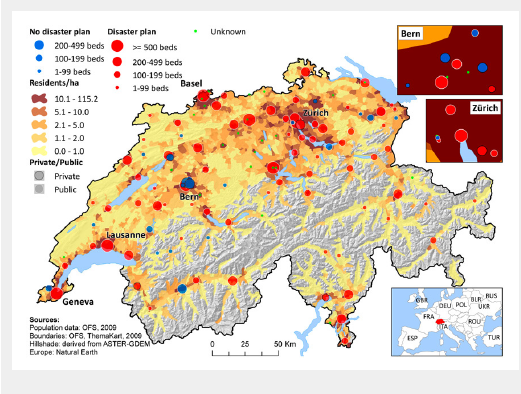
Presence of a hospital disaster plan according to ED and hospital characteristics. (Sources: Population data: OFS, 2009, Boundaries: OFS, ThemaKart, 2009. Hillshade: derived from ASTER-GDEM; Europe: Natural Earth. © Bundesamt für Statistik (BFS), Website Statistik